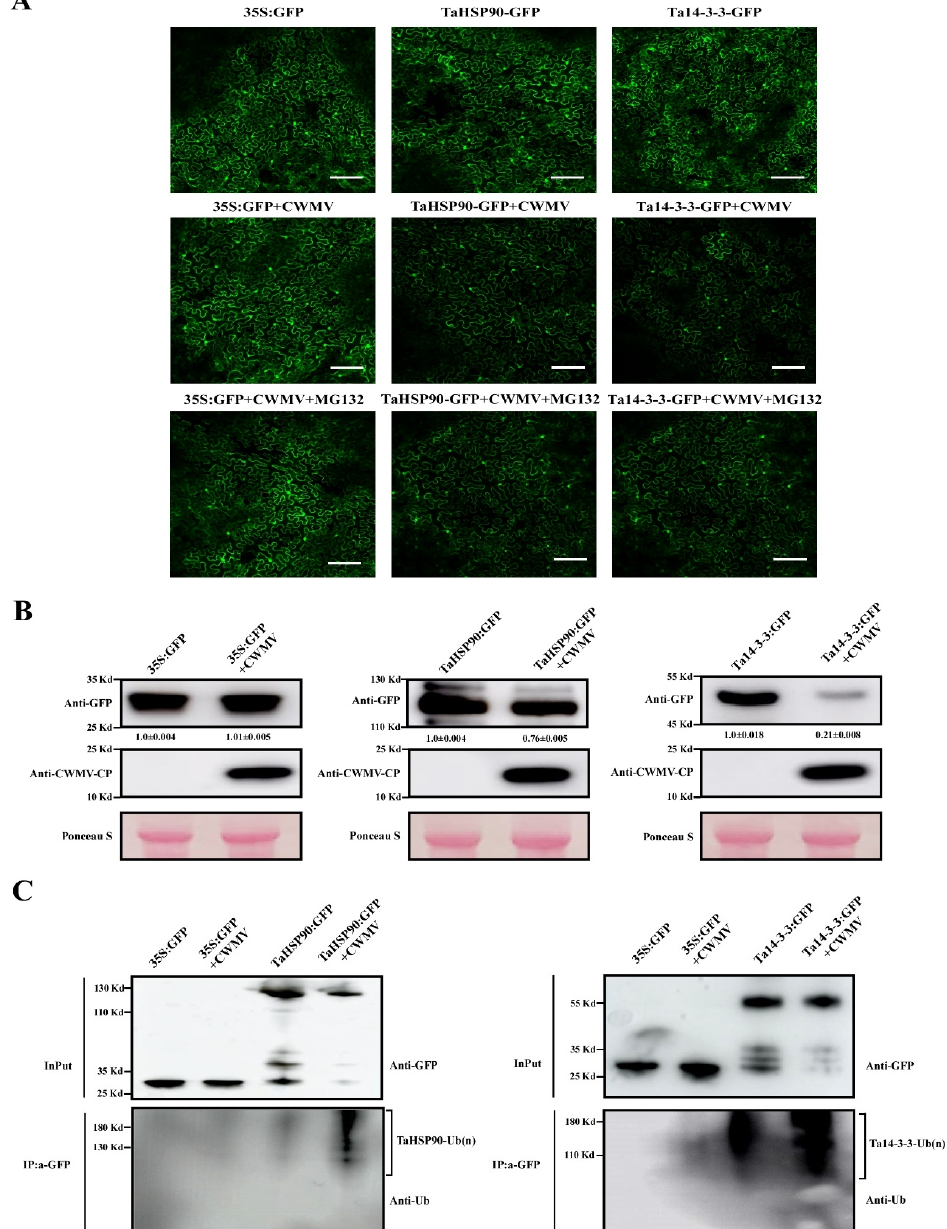
Figure 6. In vivo verification of candidate protein ubiquitination in Nicotiana benthamiana . GFP-tagged candidate proteins (including 35S:GFP, Ta14-3-3:GFP, and TaHSP90:GFP) were co-transfected with CWMV in Nicotiana benthamiana epidermal cells, where 35S:GFP acts as the negative control. Then, 100 µ M MG132 or DMSO as the control was injected into the treated leaves 36 h after inoculation. Subsequently, the fluorescence intensity ( A ) and protein accumulation ( B ) after different treatments were detected using a confocal fluorescence microscope (Nikon, Tokyo, Japan; A1 + A1R) and Western blotting, respectively. The expression levels of CWMV-CP were used to confirm infection in different samples, and then Ponceau S was used to measure protein content in different samples. ( C ) In vivo ubiquitination assay of Ta14-3-3 and TaHSP90 under CWMV infection. GFP-tagged candidate proteins (including 35S:GFP, Ta14-3-3:GFP, and TaHSP90:GFP) were co-transfected in the CWMV-infected Nicotiana benthamiana epidermal cells. Protein extracts were immunoprecipitated with GFP-Trap agarose beads (IP: α -GFP), and the ubiquitinated proteins were immunoblotted with anti-ubiquitin antibodies. The input controls are shown in anti-GFP